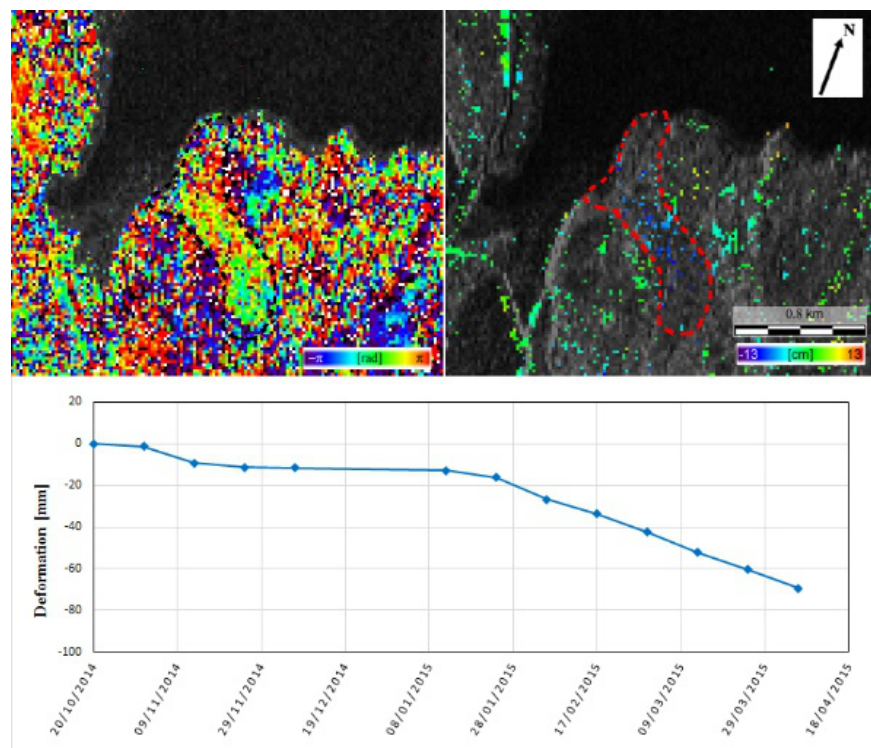
Figure 2: Example of landslide detection and monitoring using the simplified PSI approach. 12-day interferogram (upper left); accumulated deformation map (upper right); and average deformation time series (below).